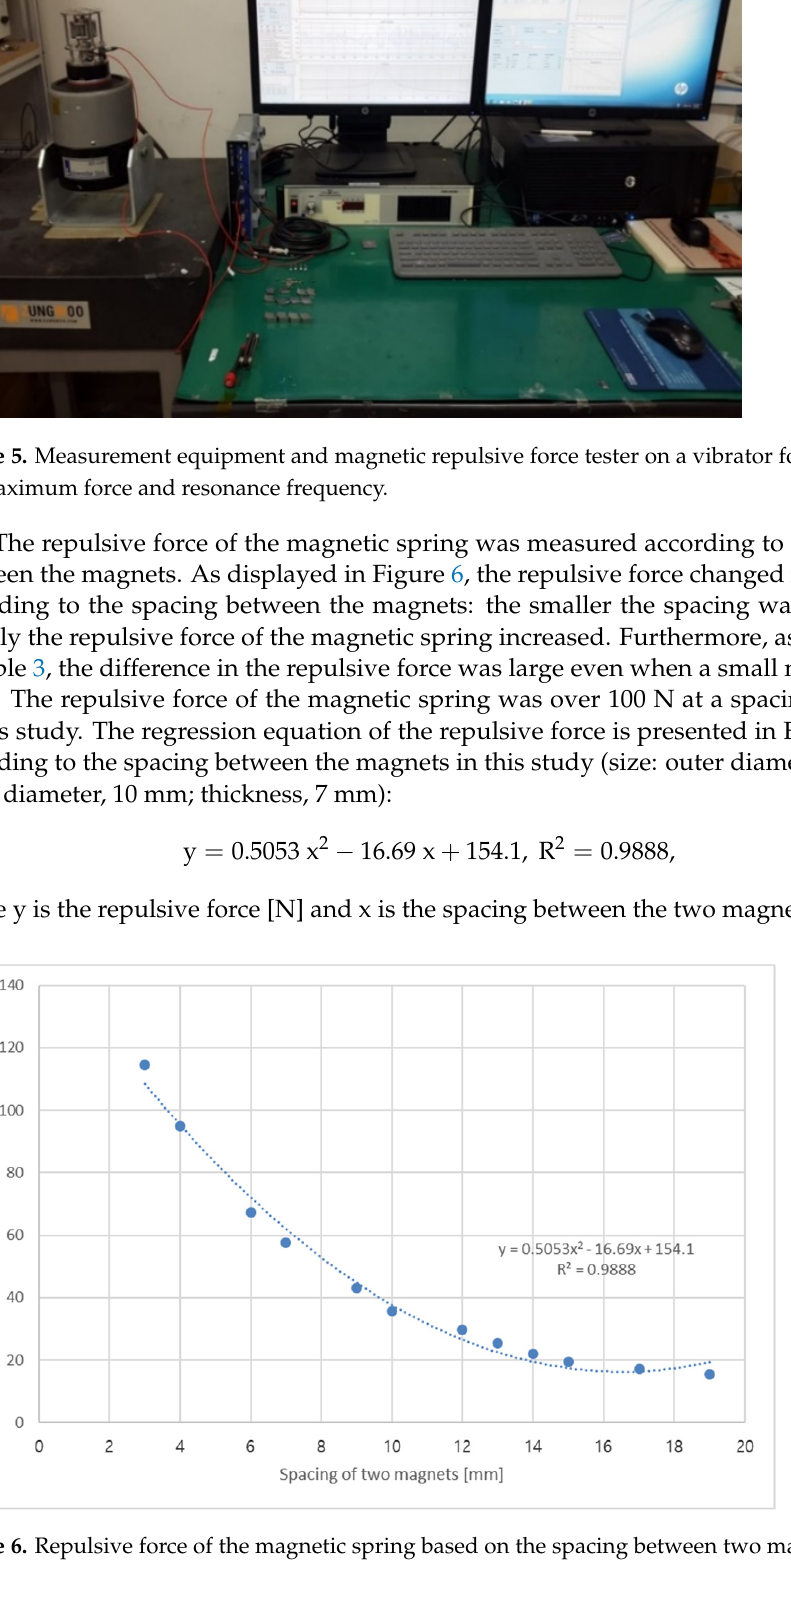
Figure 6. Repulsive force of the magnetic spring based on the spacing between two magnets.